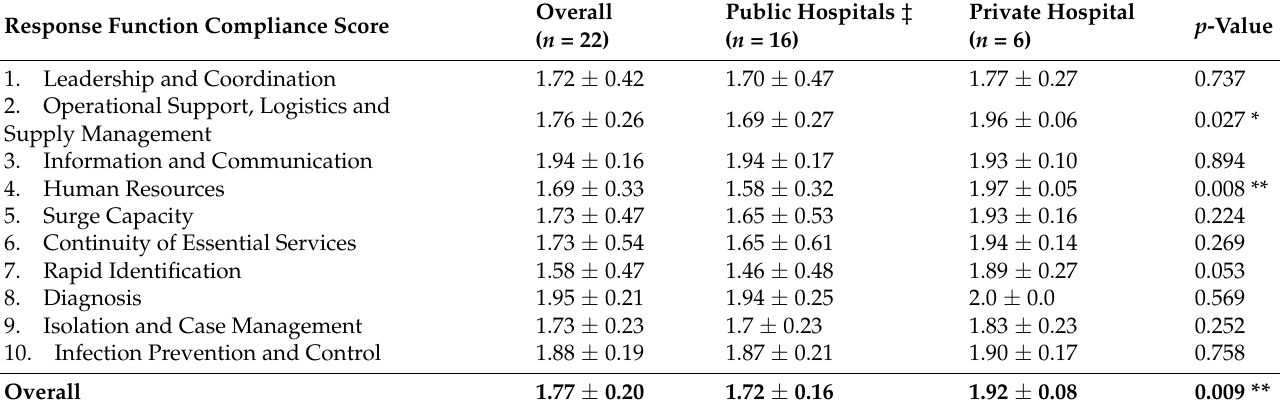
Table 2. Average compliance score of participating hospitals according to response function, stratified according to hospital type.